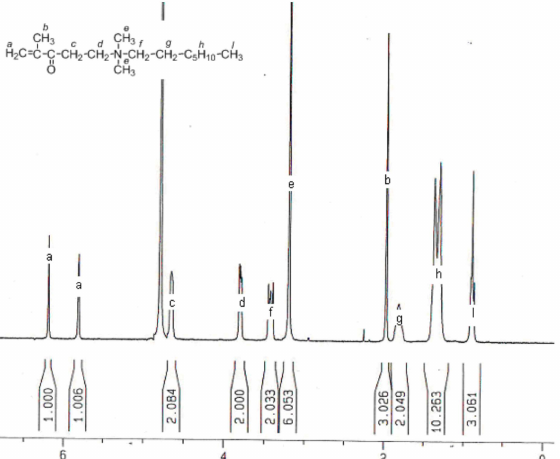
Figure 11. Typical 1 H NMR spectrum of DM-8 hydrophobic monomers.